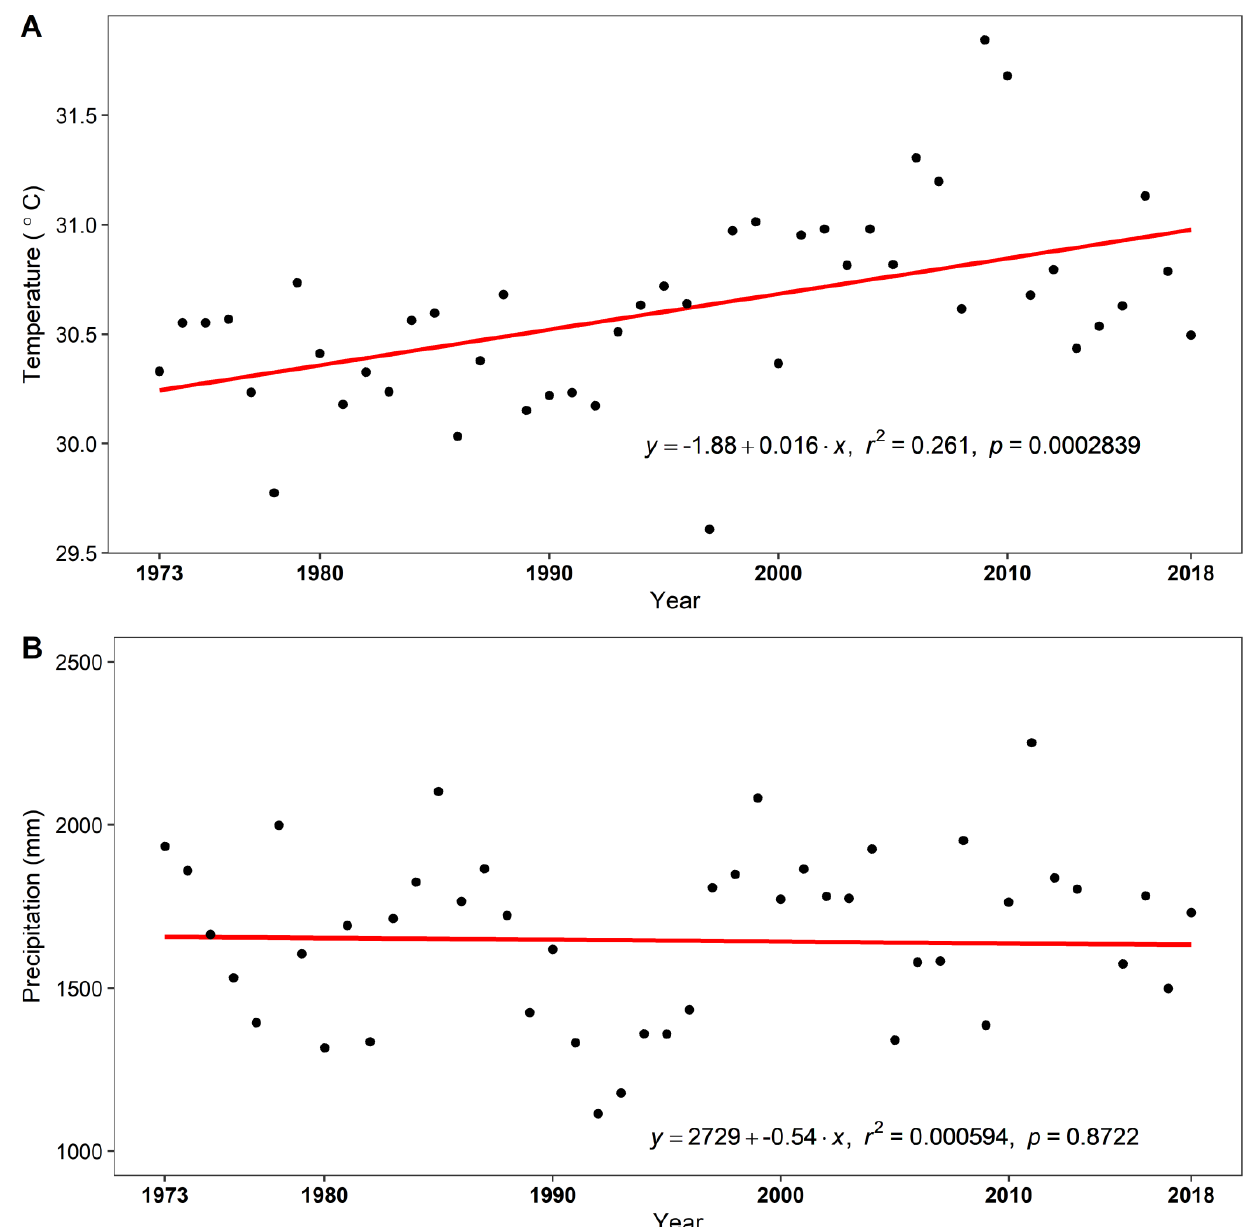
Figure 3. The trend of annual mean temperature ( A ) and precipitation ( B ) in the study area (CRU data). (CRU